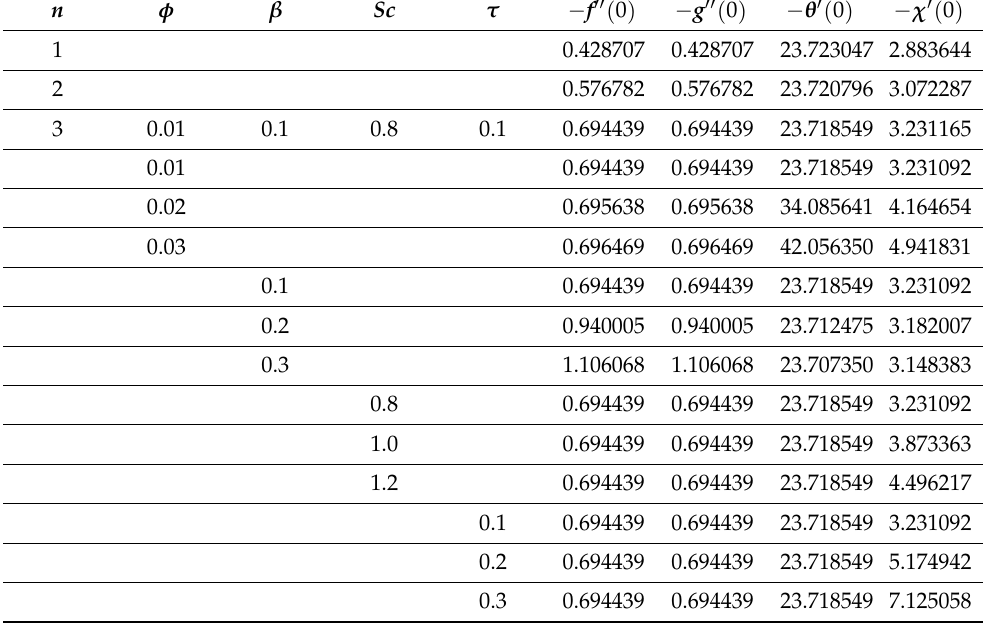
Table 4. Computational values of f (cid:48)(cid:48) ( 0 ) , g (cid:48)(cid:48) ( 0 ) , θ (cid:48) ( 0 ) , and χ (cid:48) ( 0 ) for various dimensionless constraints. When n = 3, φ = 0.01, β = 0.1,and Sc = 0.8& τ = 0.1. n